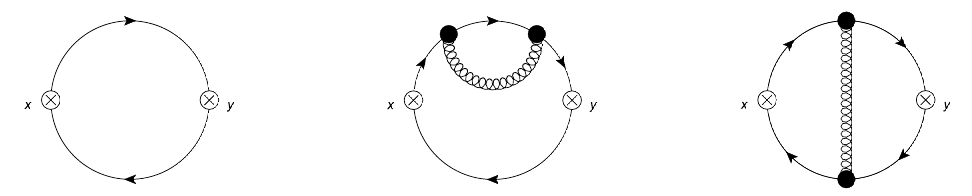
Figure 2. Contributions to (cid:5) V